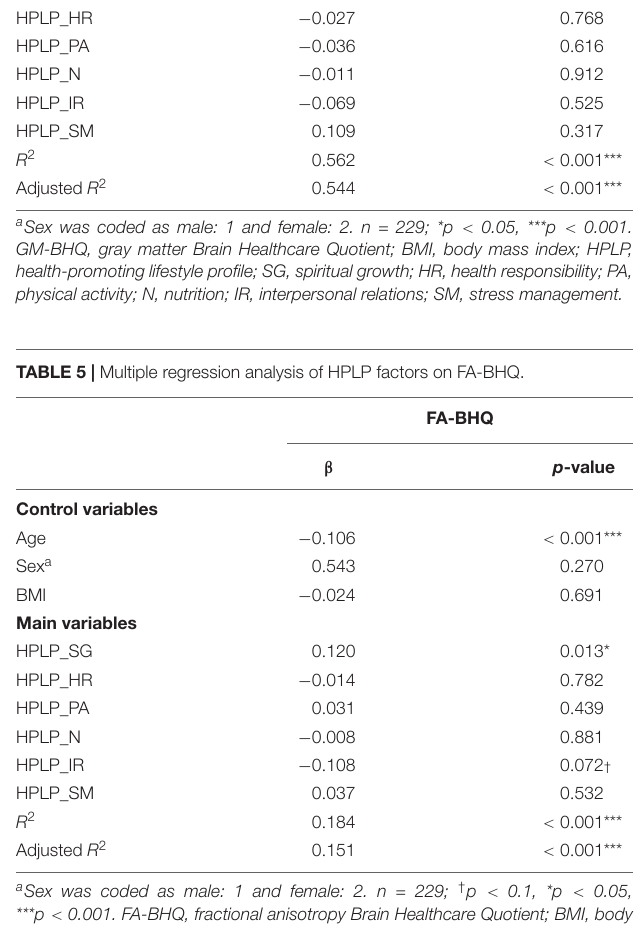
multicollinearity. As a result, for the GM-BHQ, there is a significant coefficient of determination ( R 2 = 0.562, p < 0.001).